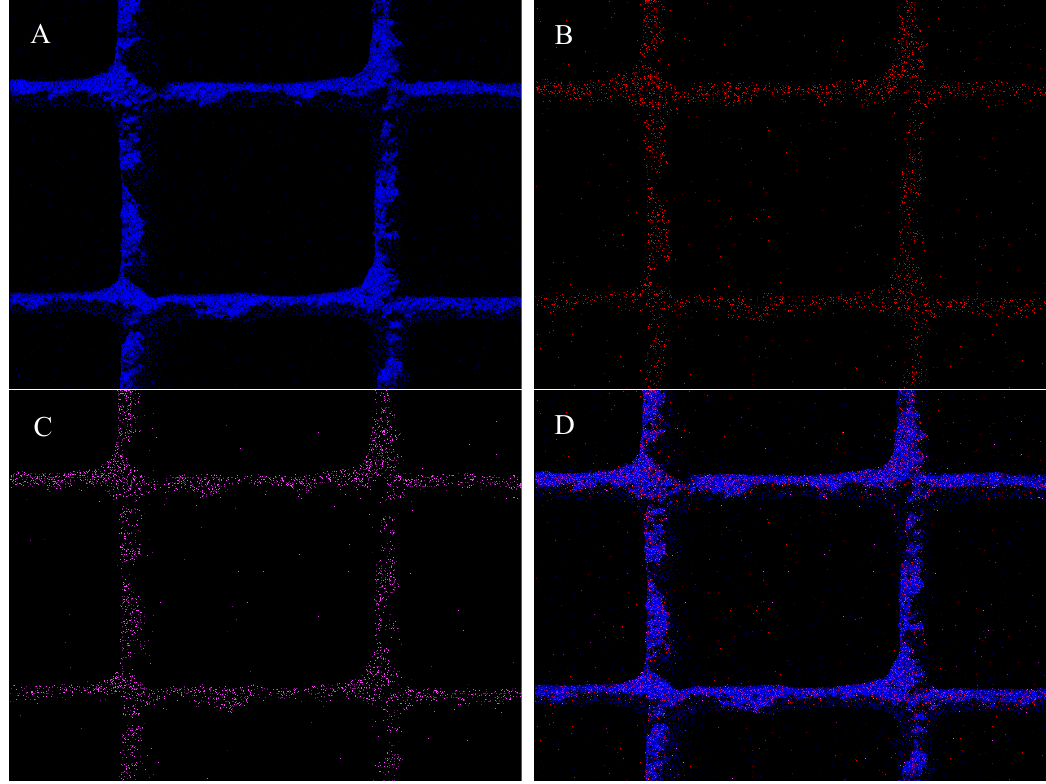
Figure 3. SEM-EDX analysis of Pd1Ce catalyst: ( A ) Al, ( B ) Ce, ( C ) Pd, and ( D ) Pd-Ce-Al. Table 2. EDX elemental analysis of the monolith catalysts. O,